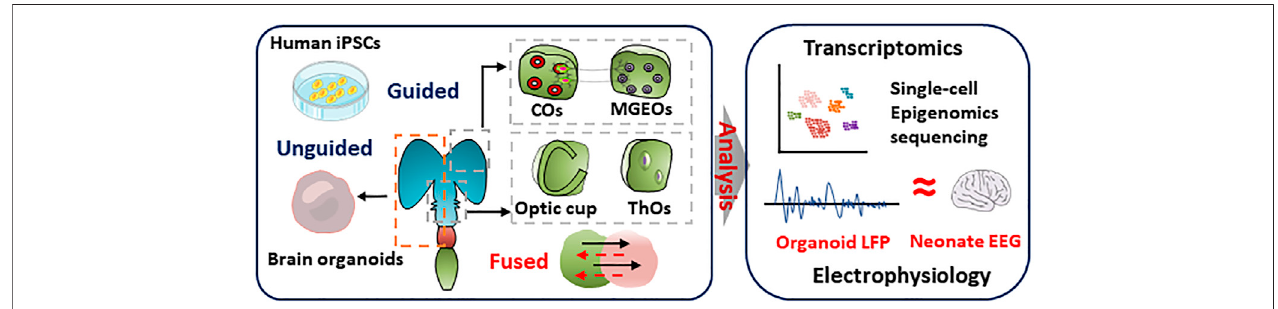
FIGURE 1 | Genetic and epigenetic regulation in the brain organoids. Top, genetics in brain organoids. iPSCs carrying ASD or SCZ pathogenic genes are derived from patients or gene editing. The mutation of ASD or SCZ are referring to the commonly mutated genes in GWAS databases, which are shown in middle. The ASD organoids showed macrocephaly, microcephaly phenotypes, and over-produced GABAergic neurons. The SCZ-organoids characterized abnormal proliferation of progenitor,reducedmatureneurons,anddisruptionofsynapticfunction.Bottom,epigeneticsinbrainorganoids.Combinedwithsingle-cellsequencing,ATACseq and CHIP-seq analyze epigenetics duringbrainorganoidsandhumanbraindevelopment,including DNAmethylation, histonevariants, non-coding RNA,and chromatin accessibility. Epigenetics can regulate timing during development. Epigenetic regulation is deeply in fl uenced by environmental factors. Exposure to toxic substances,